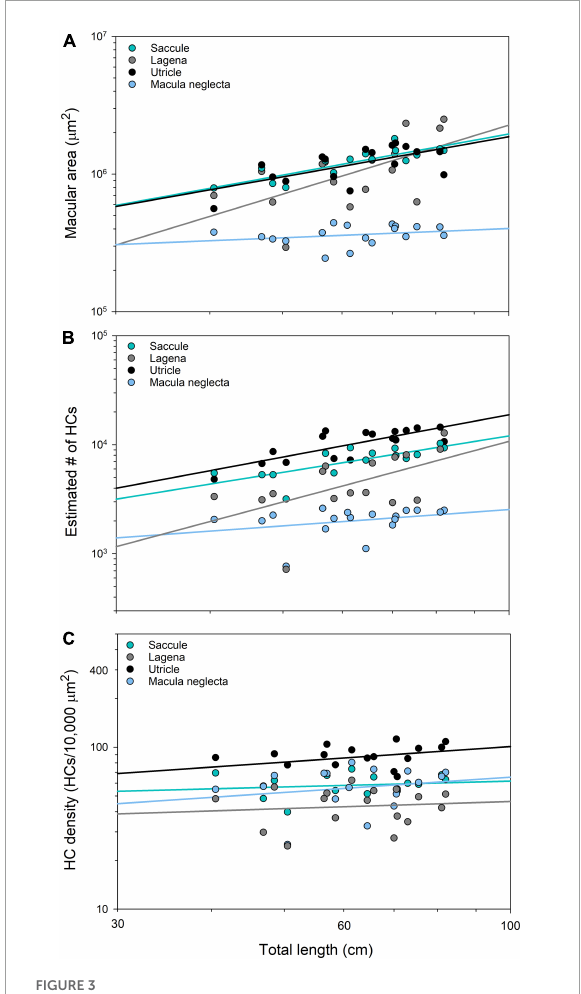
FIGURE3 Regression of total length and macular area (A) , total hair cell number (B) , and hair cell density (C) (logarithmic axes) in the four inner ear maculae of Cephaloscyllium isabellum . Macular area significantly increases with total length in all maculae except the macula neglecta (Saccule = 0.99x + 4.31, F 1 , 13 = 33.53, p < 0.001, r 2 = 0.72; Lagena = 1.67x + 3.02, F 1 , 14 = 7.93, p = 0.014, r 2 = 0.36; Utricle = 0.97x + 4.33,